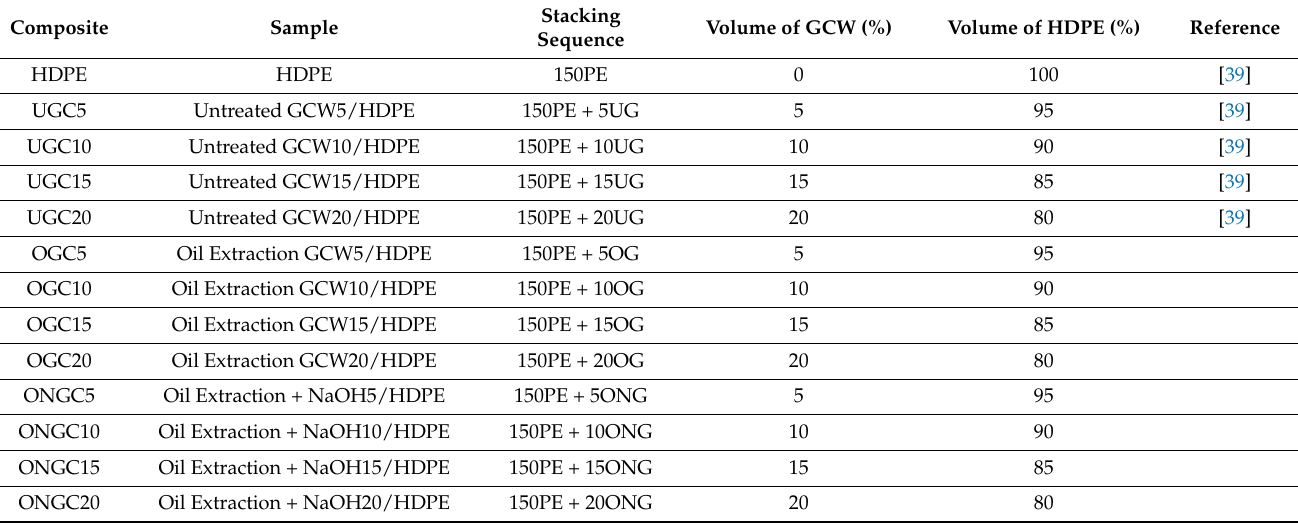
Table 3. Summary of type of composites investigated in this study.